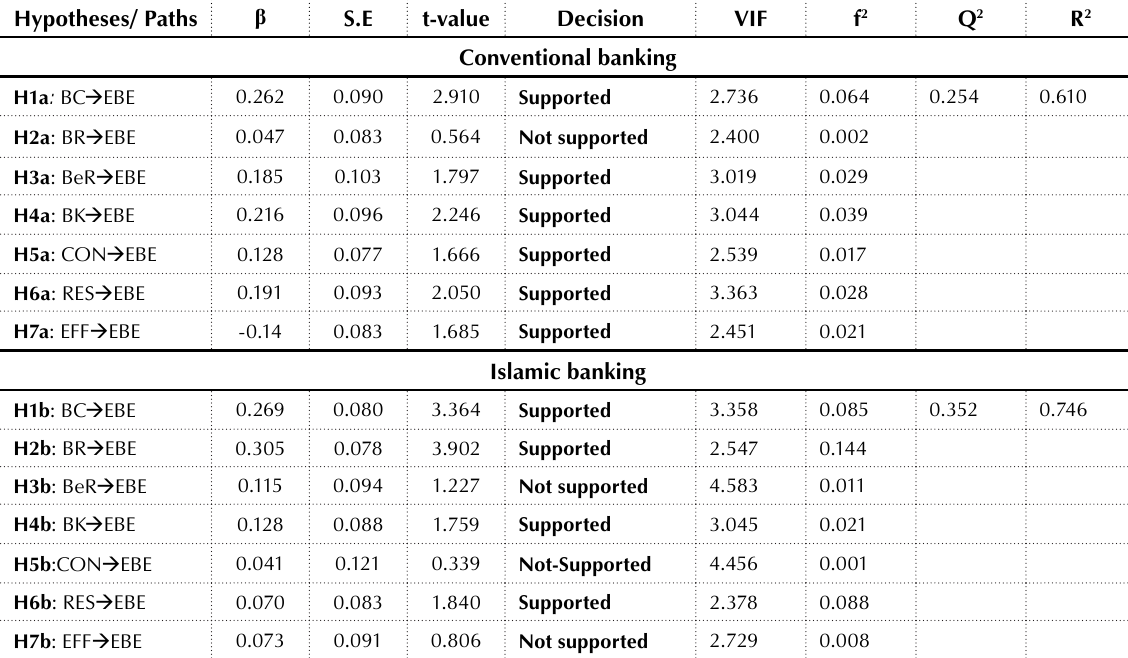
Table 3. Structural model path analysis Hypotheses/ Paths